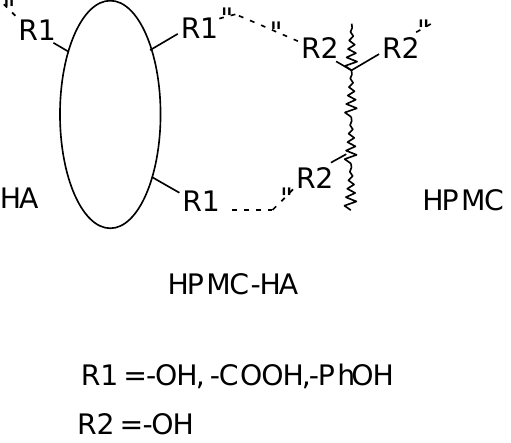
Figure 4. The structure of the hydroxypropyl methylcellulose – humic acid system, which is formed by the mechanism of matrix synthesis: НА - humic acids, НPMC— hydroxypropyl methylcellulose.